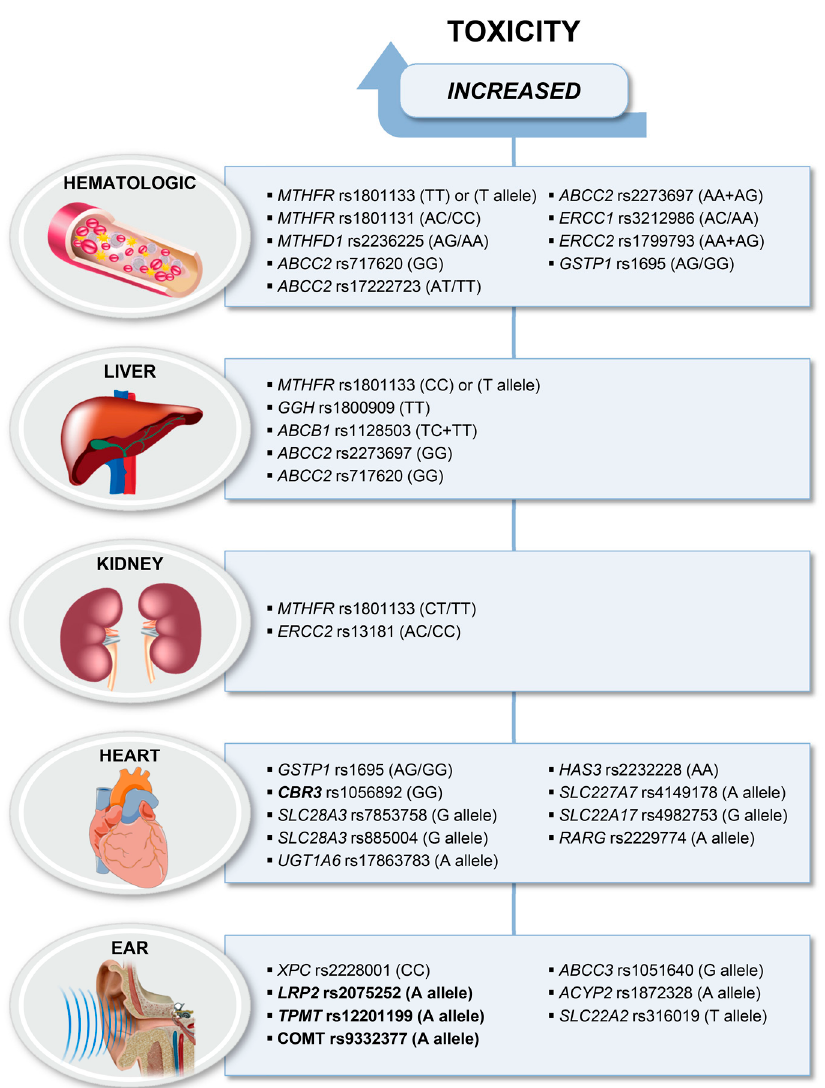
Figure 2. Pharmacogenetic variations impacting on chemotherapy-induced toxicities in high-grade osteosarcoma (HGOS). Genes, polymorphisms and corresponding genotypes (inside parenthesis) are listed inside each box. Genotypes have been reported as they were described in the original studies. Genes polymorphisms or genotypes for which contradictory results have been reported are marked in bold. Further details, abbreviations legend and references are provided in the text.